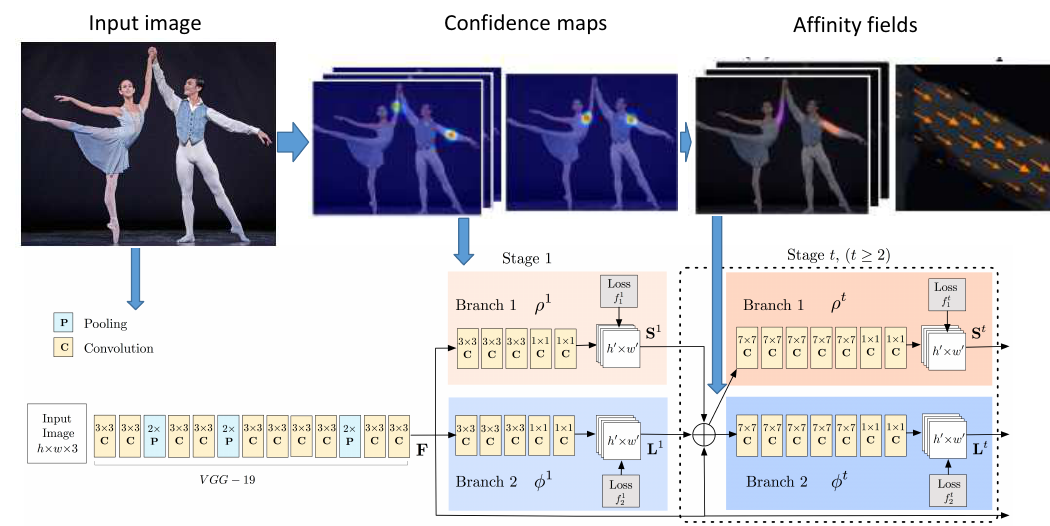
Fig. 5: The architecture of the two-branch multi-stage CNN for training the model estimation [47]